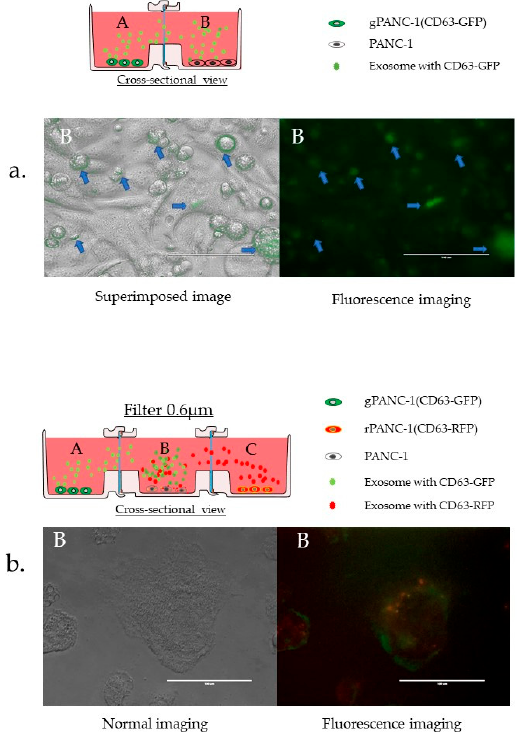
Figure 8. Confirmation of EVs migration and cellular uptake by microscope ( a ) Uptake of EVs by CD63-GFP-expressing cells. gPANC1 cells were seeded in Body A, and a photograph of Body B was taken 48 h later. ( b ) Uptake of extracellular vesicles from the both-side cells in the containers by three connected vessels. Unlabeled PANC-1 cells were seeded in Body C at the center, while gPANC1 and rPANC1 were seeded in Body A and B, respectively. Forty-eight hours later, mixed fluorescence was detected in the cells in Body